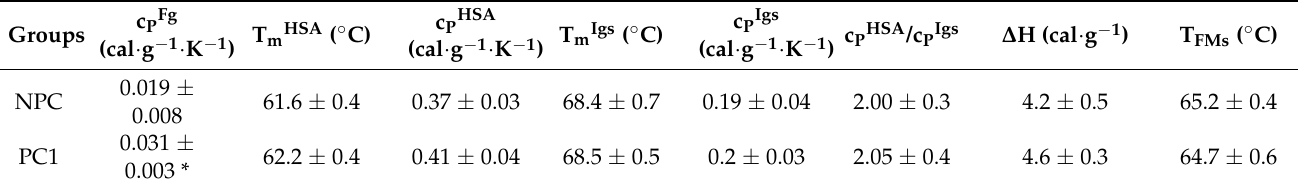
Table 2. Thermodynamic parameters (temperatures of denaturation, Tm, and excess heat capacities of the successive thermal transitions, c P ; the c P ratio of albumin and immunoglobulins assigned tran- sitions, c PHSA /c PIgs ; calorimetric enthalpy, Δ H, and weighted average center of the thermogram, T FM ), estimated from the DSC profiles of blood plasma for non-pregnant (NPC) and pregnant women in the first trimester of pregnancy (PC1).